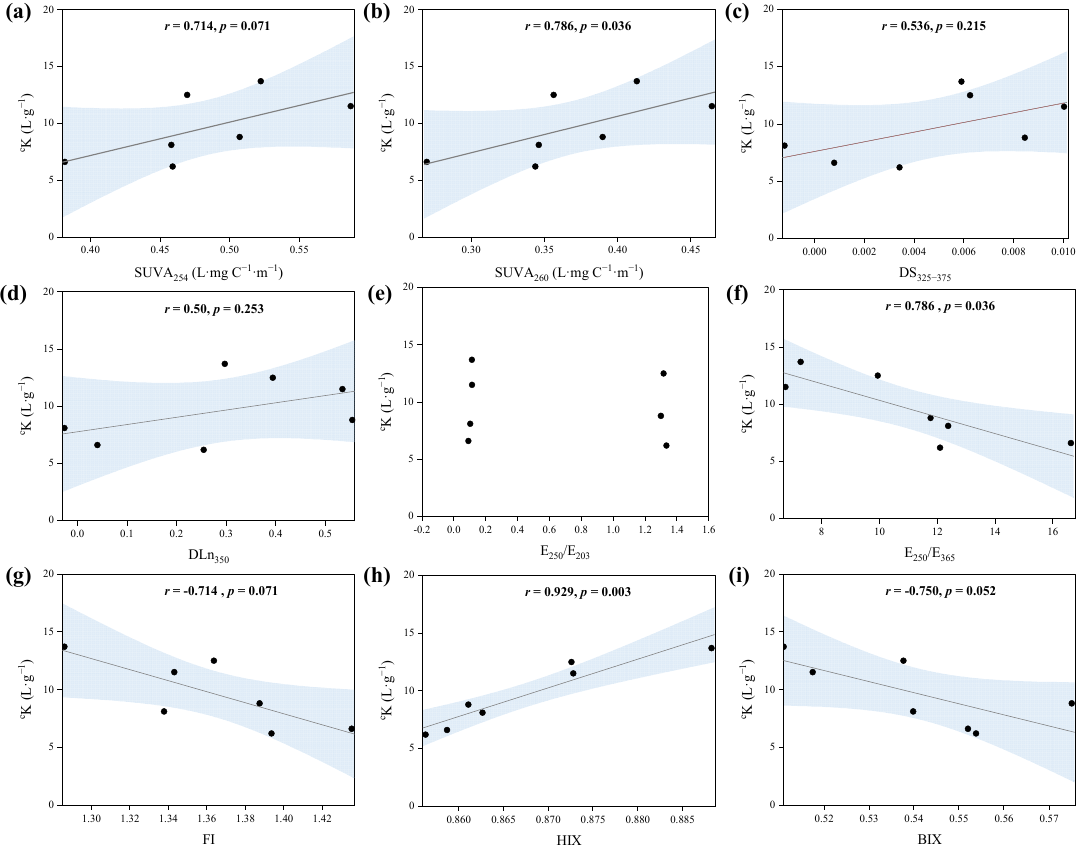
Figure 6. Spearman’s rank correlations between cK and PPFA optical parameters, including ( a ) specific UV absorbance at 254 nm (SUVA 254 ), ( b ) specific UV absorbance at 260 nm (SUVA 260 ), ( c ) DS 325–375 , ( d ) DLn 350 , ( e ) E 250 /E 203 ( f ) E 250 /E 365 , ( g ) fluorescence index (FI), ( h ) humification index (HIX) and ( i ) biological index (BIX).